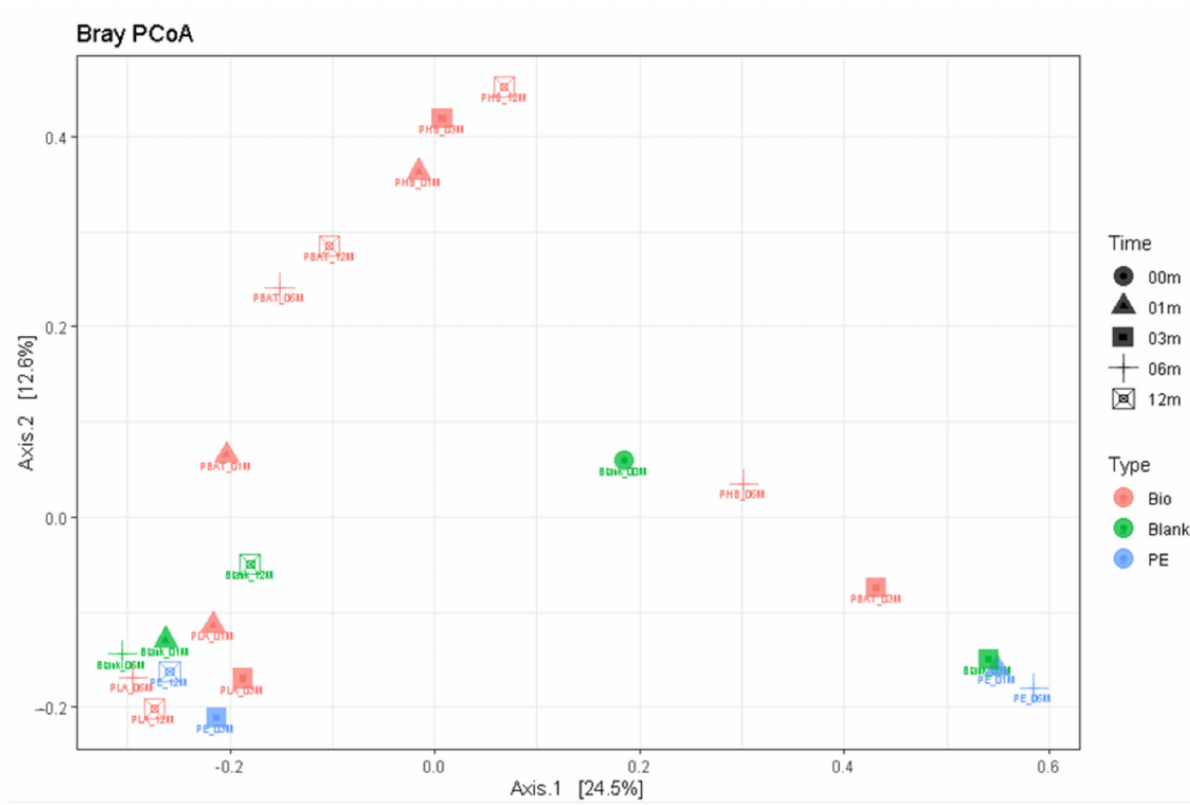
Figure 12. Principal component analysis based on 18S